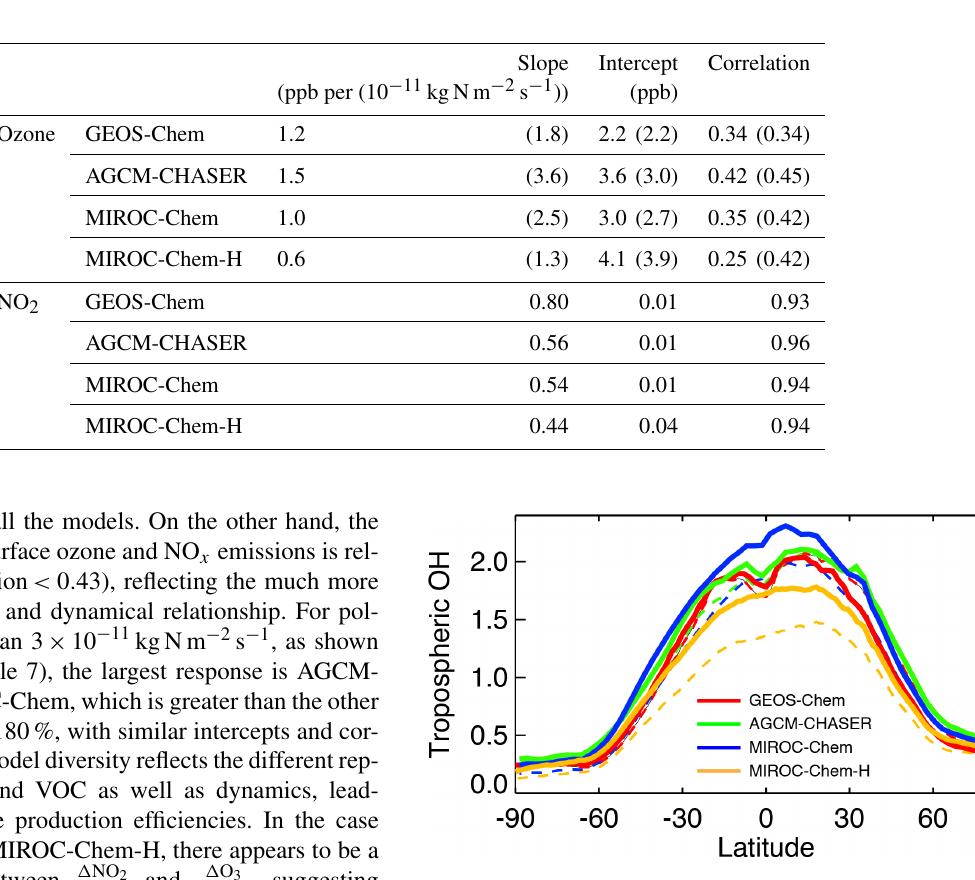
Figure 14. Latitudinal distributions of annual and zonal mean OH concentrations (10 6 moleculescm − 3 ) averaged over the tropo- sphere obtained from the control runs (dotted lines) and data assim- ilation analyses (solid lines) for the four